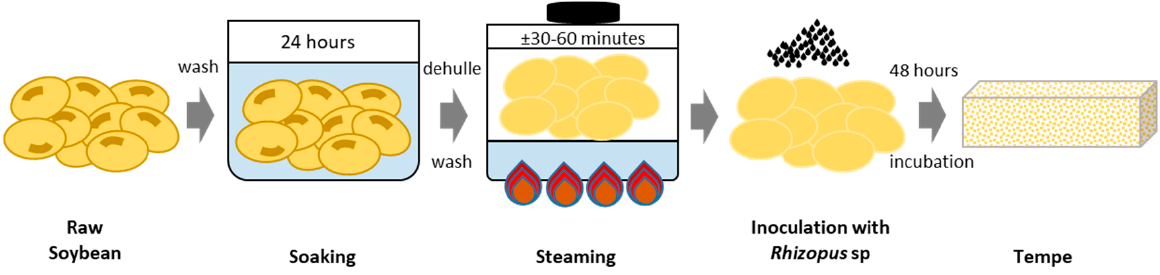
Figure 1. Tempe production process. Raw soybeans were sorted and soaked for 24 h at room temperature. They were washed and peeled to remove the skin from the bean, steamed for 30–60 min, and then cooled and dried after the steaming process was complete. Fungal fermentation was performed by pouring the starter inoculum into the dry soybeans and wrapping them in perforated plastic for 48 h. The general steps of this tempe production research were as follows: raw soybean (RS), soaked soybean (SS), steamed soybean (StS), fungal fermentation (FF), and over-fermentation (OF).